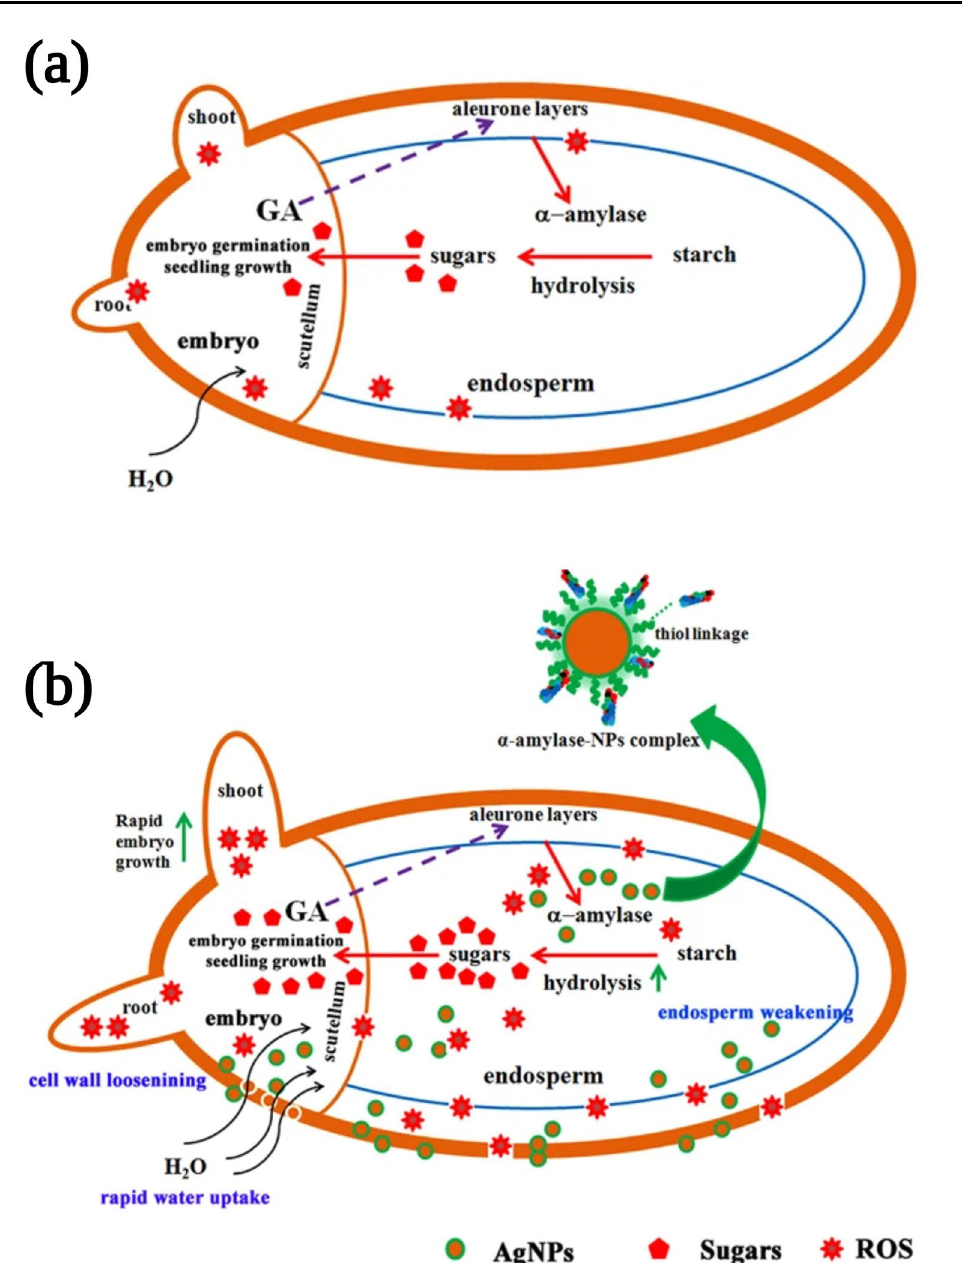
Fig. 3 Phytosynthesized silver nanoparticles enhance aged rice seeds’ germination and starch metabolism. a Seeds without silver nanoparticle priming treatment have lower metabolic activity because of slow water uptake, and starch is hydrolyzed slowly; as a result, sugar levels are low in the initial stage of imbibition, resulting in slow seed germination and growth. b Silver nanoparticle seed priming enhances seed germination. This is a reprinted image of Ref. [119] with